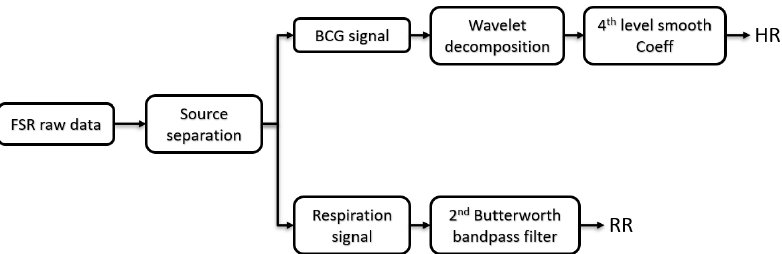
Figure 3. The signal processing was performed in two pipelines using discrete wavelet transform and Butterworth bandpass